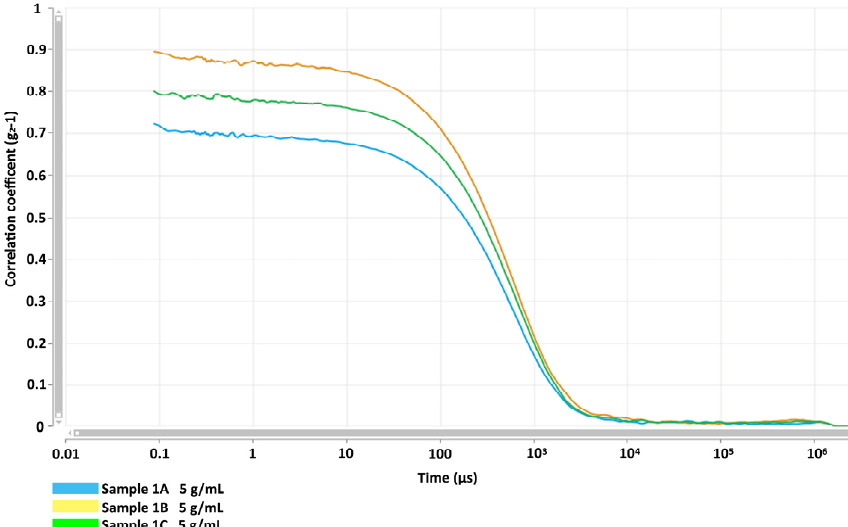
Figure 2. GlcNAc NP autocorrelation functions regarding the effects of sample dilutions and scat- tering at a fixed angle. Samples were obtained from three independent preparations: Sample 1A (blue line), Sample 1B (yellow line), and Sample 1C (green line). The intercepts of curves show that all coefficients are inside the range from 0.7 to 0.9 and the curve slopes suggest a low effect of scattering among particles with different sizes.